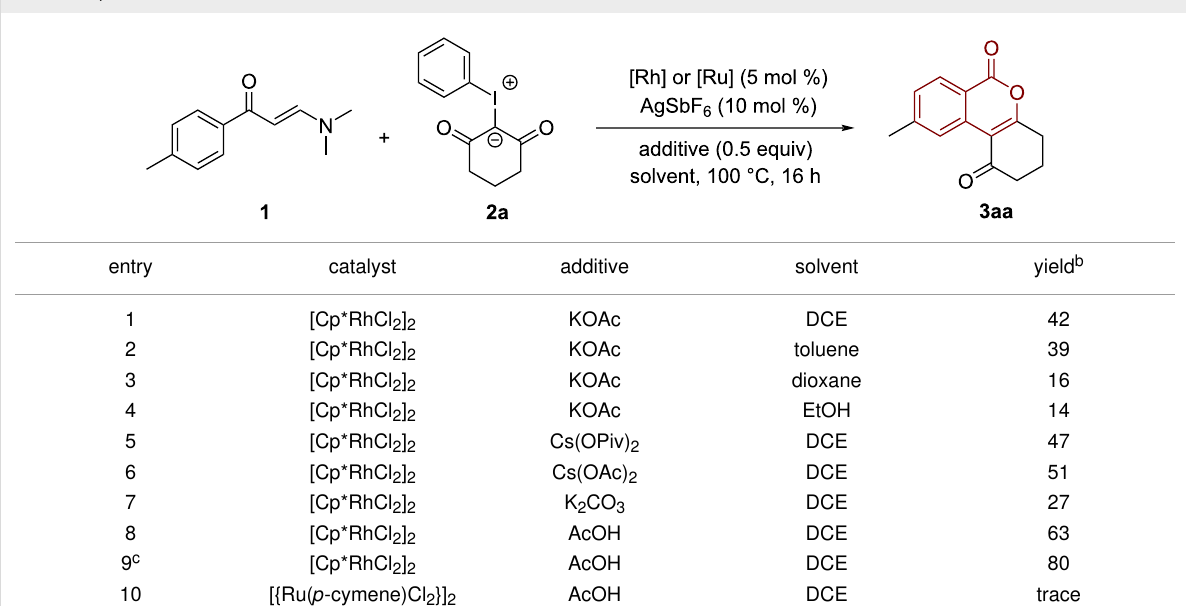
Table 1: Optimization of the reaction conditions a